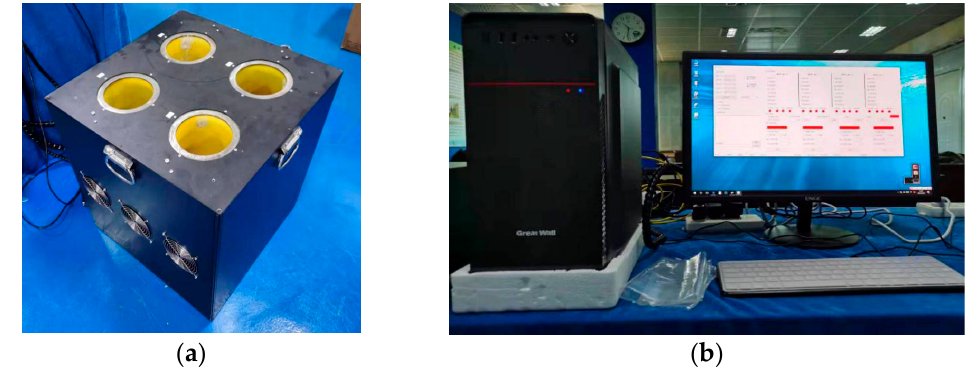
Figure 3. The experimental system based on the electromagnetic heating method. ( a ) The electromagnetic heater. ( b ) The control system.